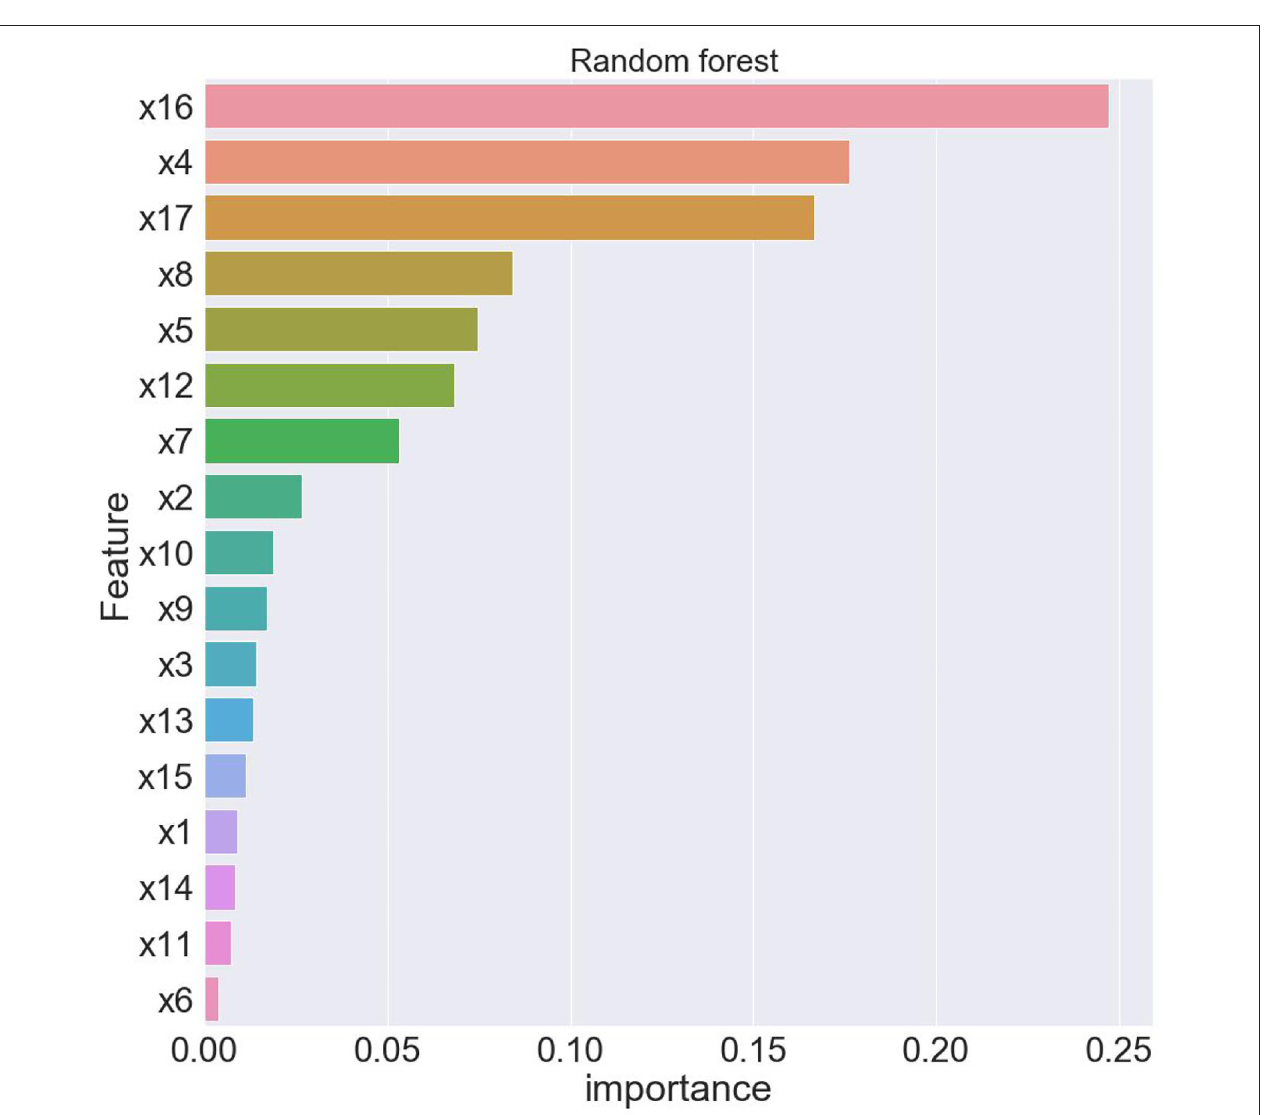
FIGURE 4 | Feature ranking of random